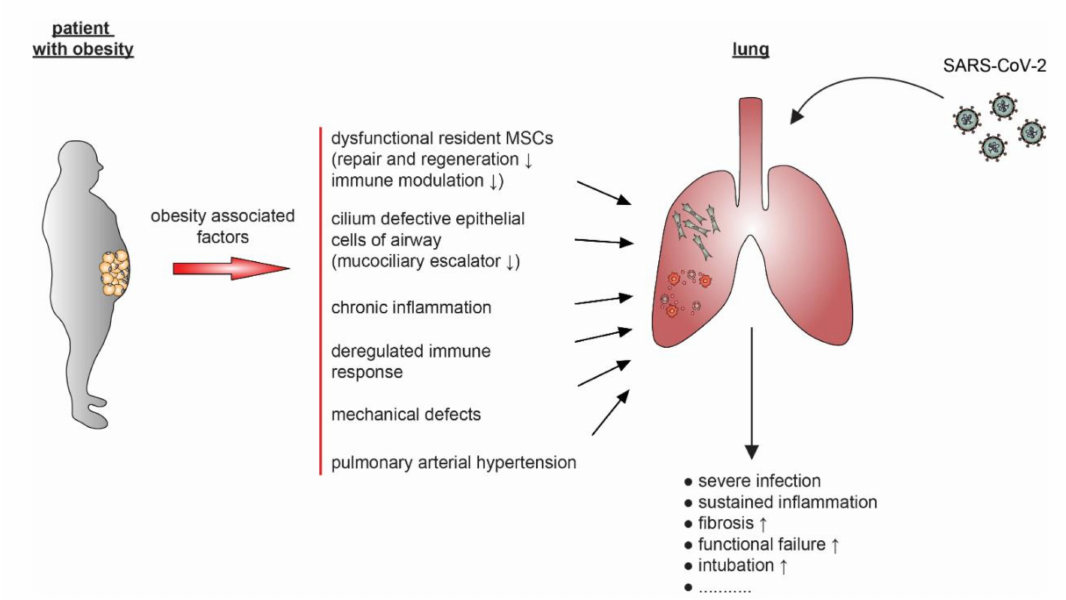
Figure 2. A model showing negative e ff ects of obesity on the pulmonary pathogenesis of COVID-19. Obesity-associated aspects, including defective immune response, chronic inflammation, dysfunctional MSCs, compromised ciliated airway epithelial cells, mechanical defects, and pulmonary arterial hypertension, impair the lung defense system against SARS-CoV-2 infection and cause worse outcome of obese COVID-19